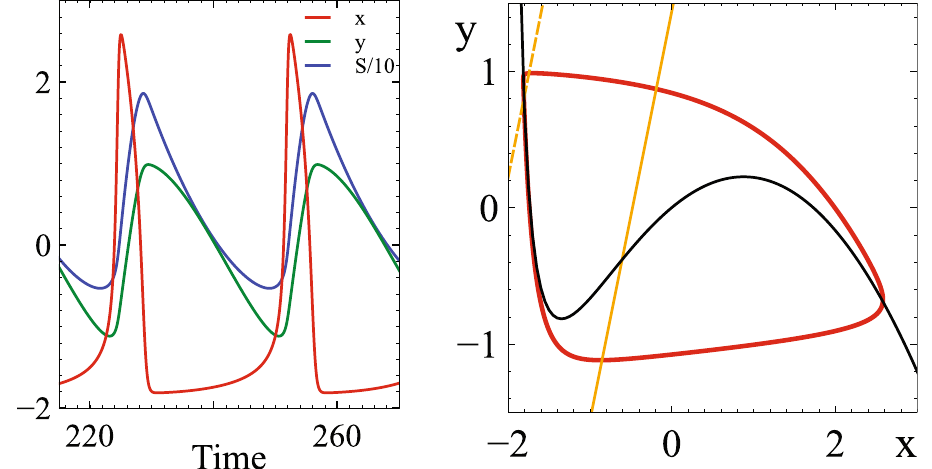
Figure 10. In the relaxation oscillator (equations (11,12,13)) the coupling field S reflects the oscillation wave form and affects the stability of the fixed point. ( A ) Temporal evolution of x , y , and S for the relaxation oscillator and ( B ) corresponding projection onto the ( x , y )-phase plane. Black: x -nullcline, gold: y -nullclines corresponding to the minimal (solid) and the maximal (dashed) value of S along the limit cycle. Parameters: = . 0 05